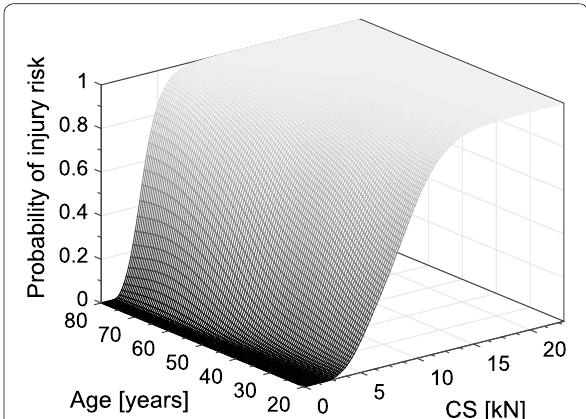
Fig. 6 Risk curve for specific ages estimated via the kernel density estimation. CS, compressive strength